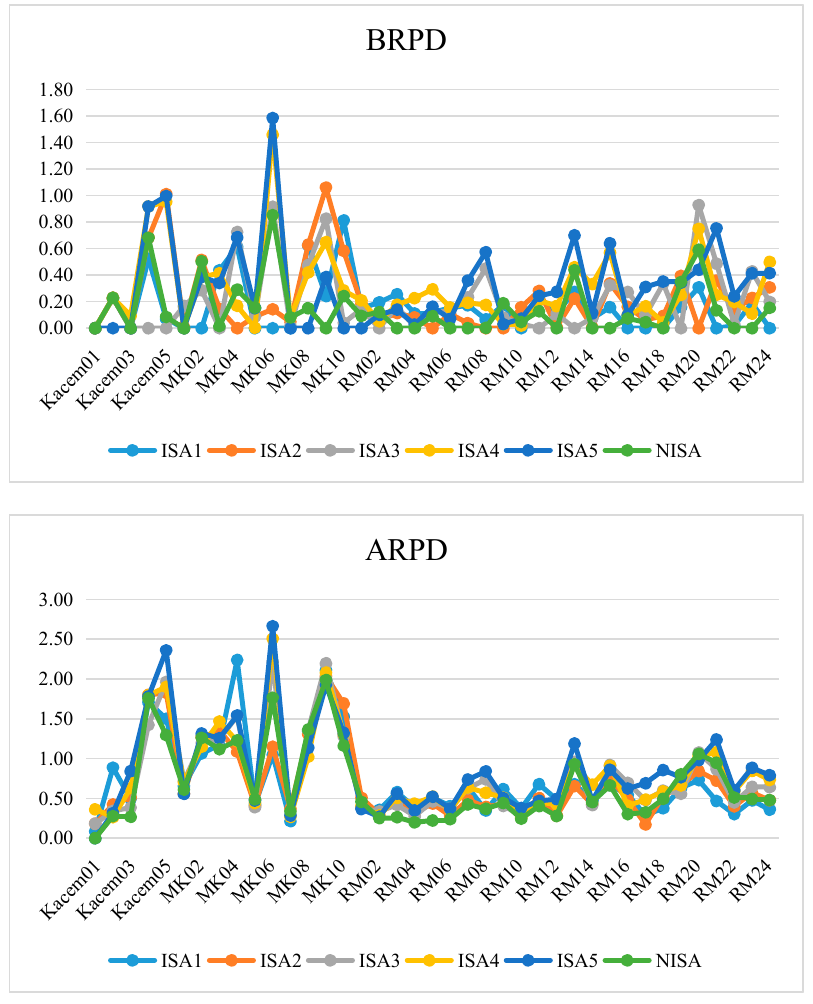
Figure 5. The curves of BRPD and ARPD in the comparison between NISA and ISA1-5. Table 5. Effectiveness analysis of the dynamic adjustment on λ .